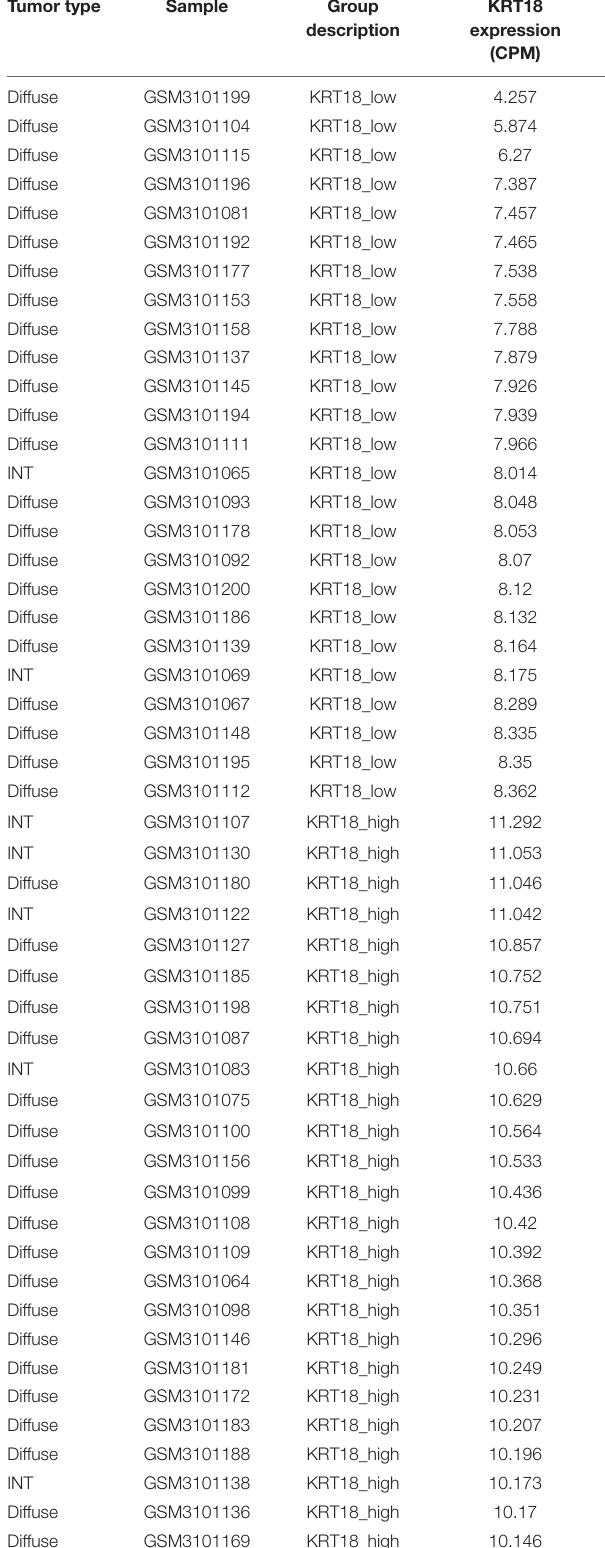
TABLE 3 | The samples were grouped based on their KRT18 expression level regardless of tumor